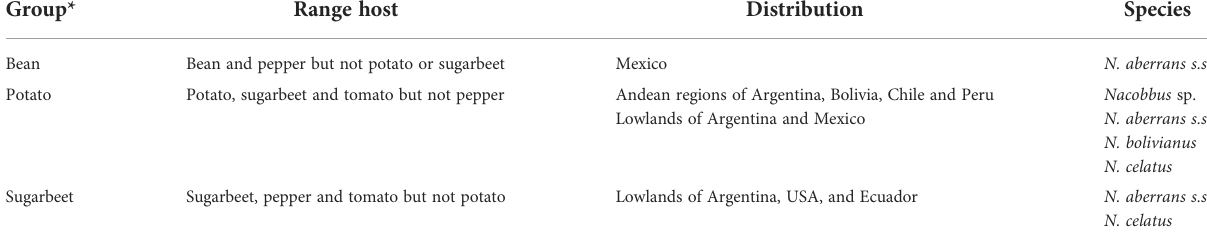
TABLE 1 Host range and distribution of physiological groups of Nacobbus spp. based on host preference. Group* Range host Distribution Species